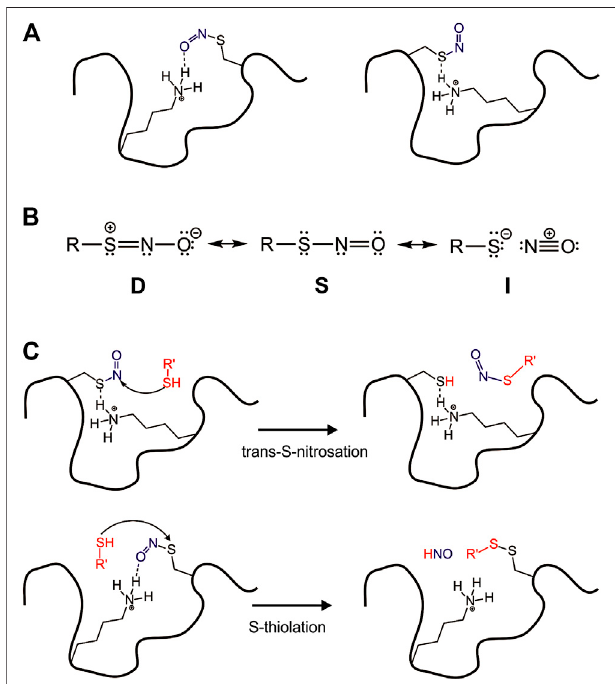
FIGURE 4 | Surface effect on the reactivity of S-nitrosation site. (A) Surfaceinteractionsmodulating – SNOgroupintheprotein; (B) RSNOasthree resonance structures; (C) The protein environment driving nucleophilic attack in different positions in the